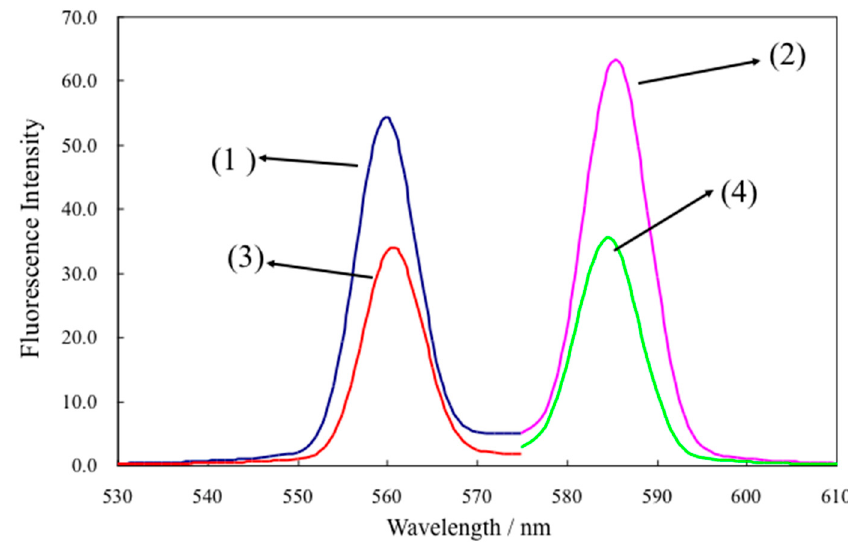
Figure 3. The excitation and fluorescence spectra of the L-RB film after it was immersing to a 5.0 µ M NaTPBF solution (pH 4.0, adjusted with a 0.1 M CH 3 COOH/CH 3 COONa buffer solution) (1: excitation spectrum), (2: fluorescence spectrum), and that of the pH 4.0 buffer solution (0 μ M NaDBS solution) (3: excitation spectrum), (4: fluorescence spectrum) for 30 min, respectively.